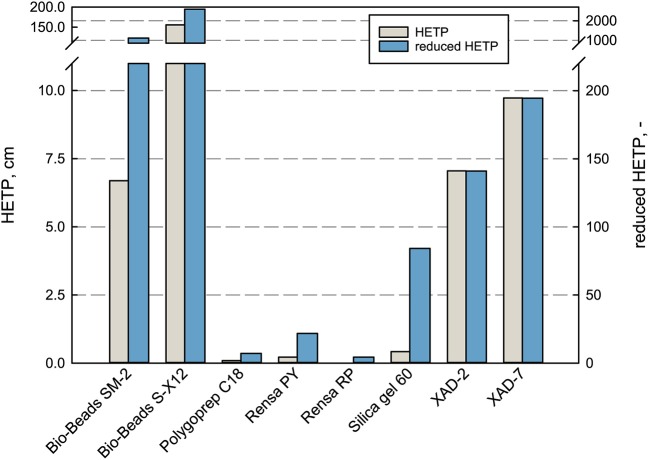
Performance characterization of the packed bed adsorbents in terms of HETP and reduced HETP. The values were determined at 100% DI H2O with uracil at 1 mL min−1 flow rate.